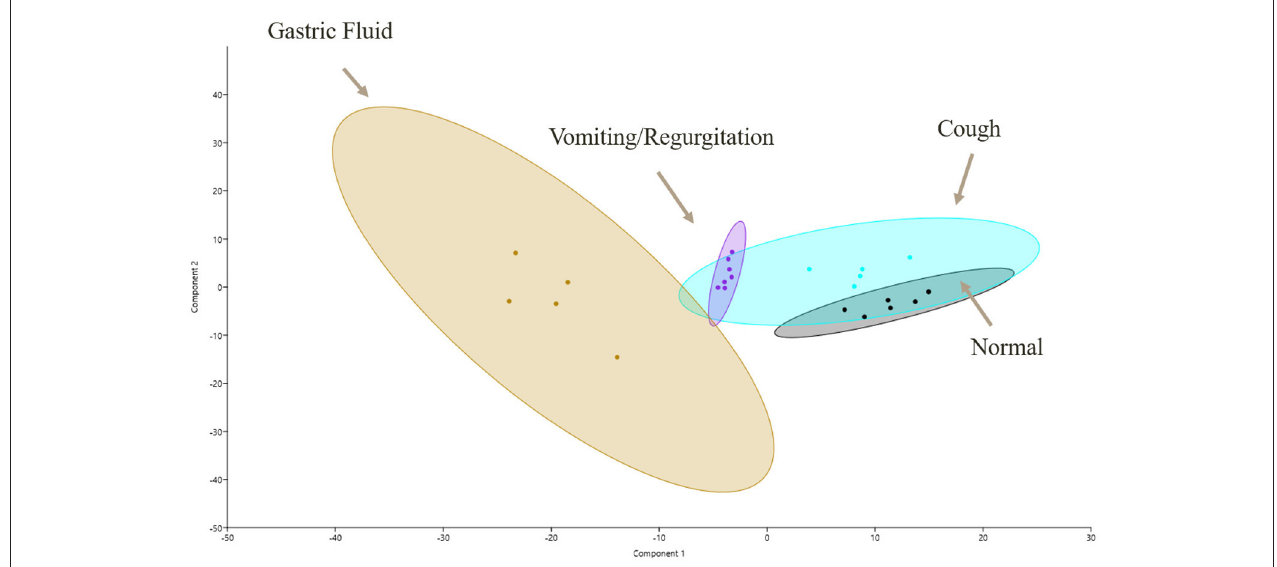
FIGURE 3 | Functional proteomic profiles as shown via principal component (PC) analysis of samples for all four sample sites: GF (yellow), normal OP (gray), coughing OP (blue), and vomiting/regurgitating OP (purple). Similarities in proteomic profiles are demonstrated by overlapping regions on the PC1 vs. PC2 plot. Each dot represents an individual sample, and the ellipses represent 95% confidence intervals. GF, gastric fluid; OP, oropharyngeal.